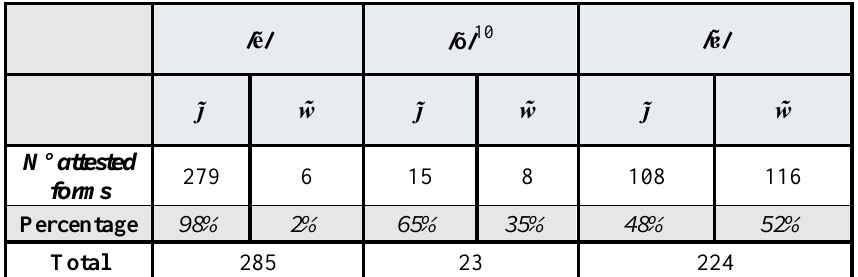
Table 3. Number and percentage of front and back offglides in the ALEPG corpus according to the vowel that diphthongizes